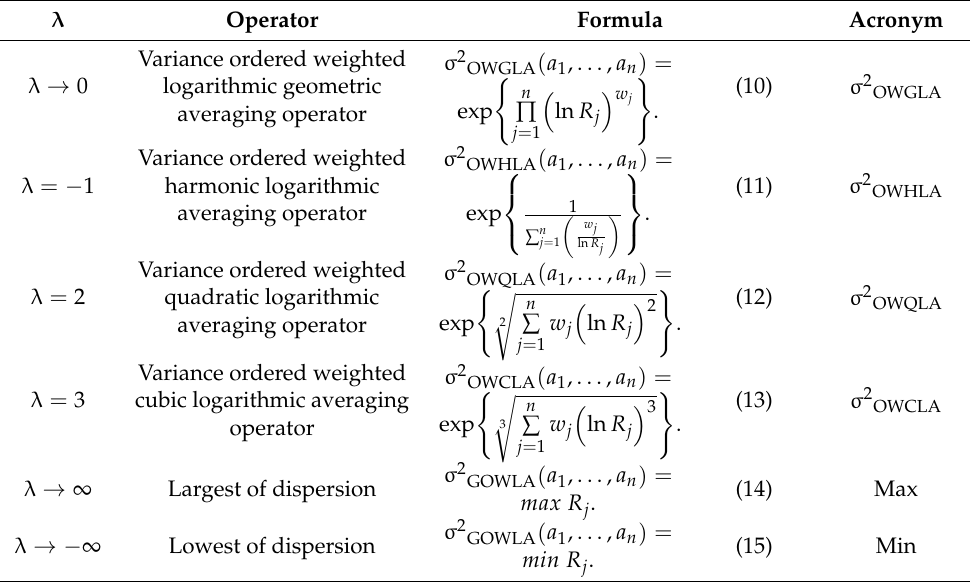
iation of the λ vector in the Var-GOWLA operator, including the variance ordered weighted logarithmic geometric averaging operator (Var-OWGLA), variance ordered weighted harmonic logarithmic averaging operator (Var-OWHLA), variance ordered weighted quadratic logarithmic averaging operator (Var-OWQLA), and variance ordered weighted cubic logarithmic averaging operator (Var-OWCLA), and both the largest and the lowest of the dispersion. Table 1. Families of the Var-GOWLA Table 1. Families of the Var-GOWLA operator.